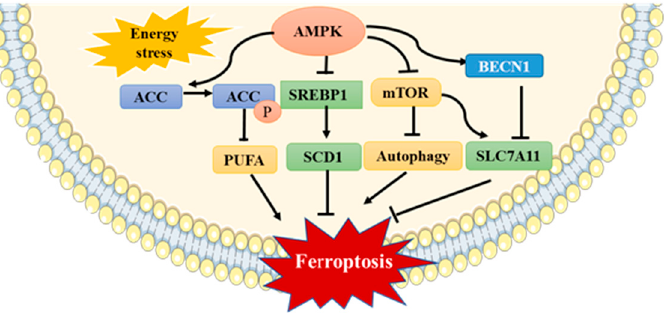
Figure 4. Regulatory effect of AMPK on